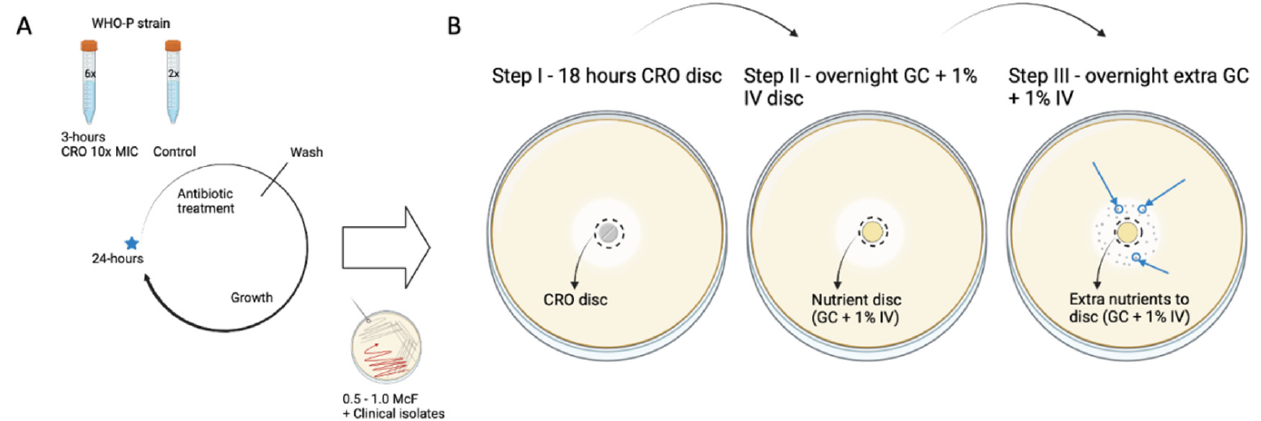
Figure 5. Induction of tolerance to CRO in WHO P N. gonorrhoeae reference strain and clinical isolates, detection via a CRO TD test. ( A ) Cyclic 3 h 10 × MIC ceftriaxone interval exposure (n = 6) with two control samples not exposed to CRO. ( B ) TD test after every 24 h exposure cycle of reference strain samples (n = 6) including controls and clinical (n = 18) N. gonorrhoeae isolates with 0.008 µ g CRO discs [14,25]. Blue star indicates the point at which cyclic exposure samples were inoculated, tested for MIC, and stored. Blue arrow indicates emergent tolerant colonies at Step III.